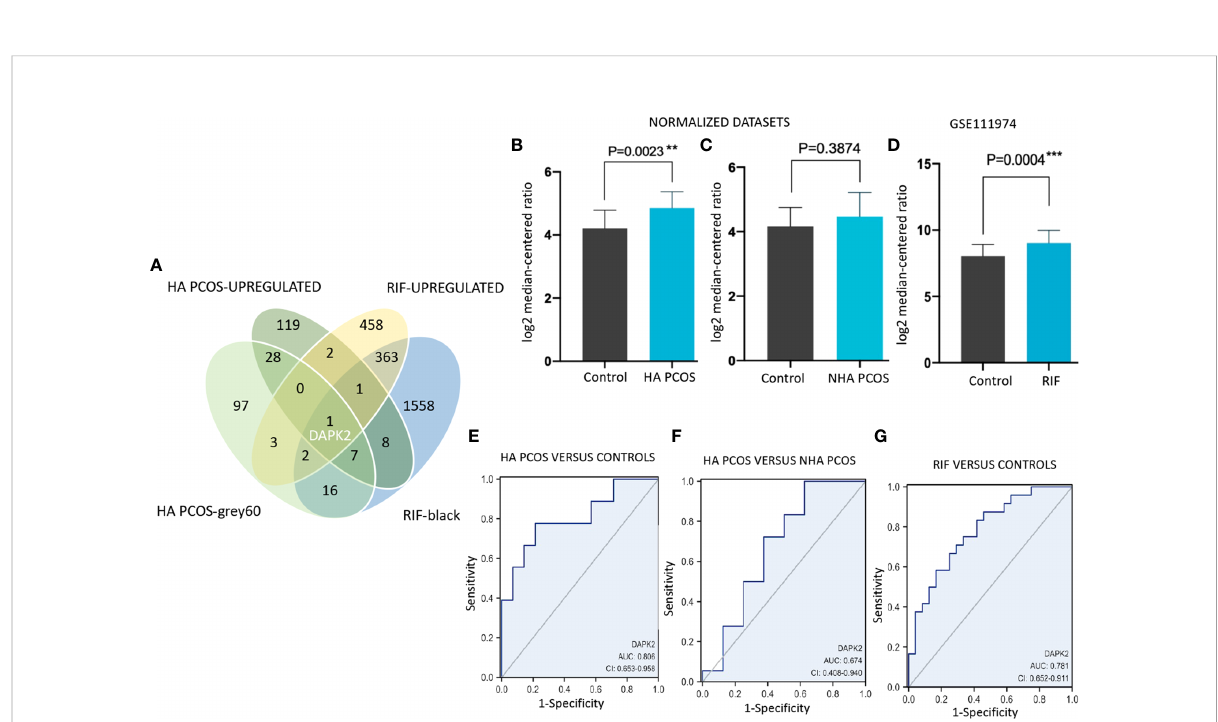
FIGURE 5 Identi fi cation and validation of DAPK2 in PCOS and RIF datasets. (A) Upregulated DEGs and genes of co-expressed modules in HA PCOS and RIF are intersected and DAPK2 is selected out. (B – D) Differential expression of DAPK2 between HA PCOS, NHA PCOS, RIF patients and controls. (E – G) ROC diagnostic curve for DAPK2 in HA PCOS versus controls, HA PCOS versus NHA PCOS and RIF versus controls respectively. * p < 0.01, *** p <